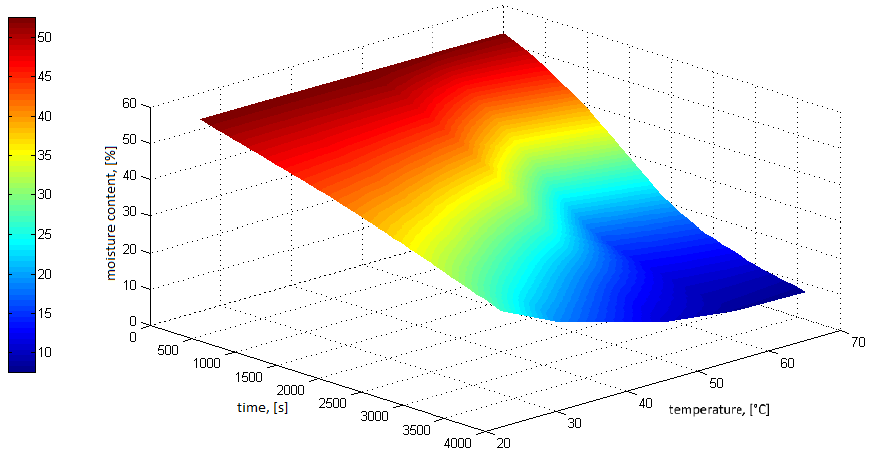
Figure 18. Plane diagram of the drying process, 3D installation; Bełchatów; 0–8 mm; temperature 27–50 °C.